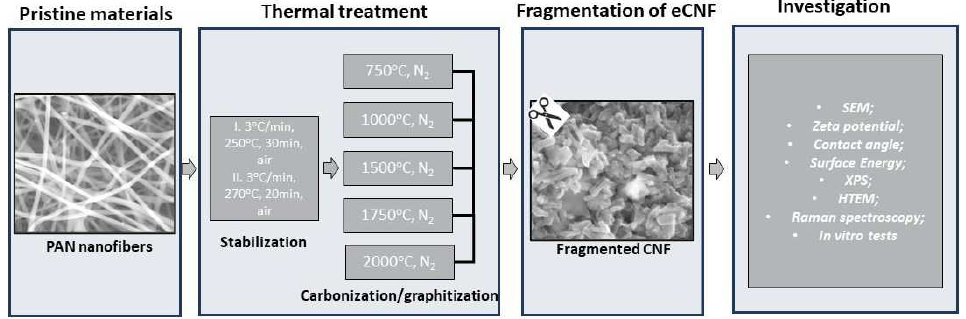
Figure 12. Schematic diagram of the individual stages of preparation and investigation of carbon nanofibers (CNF).